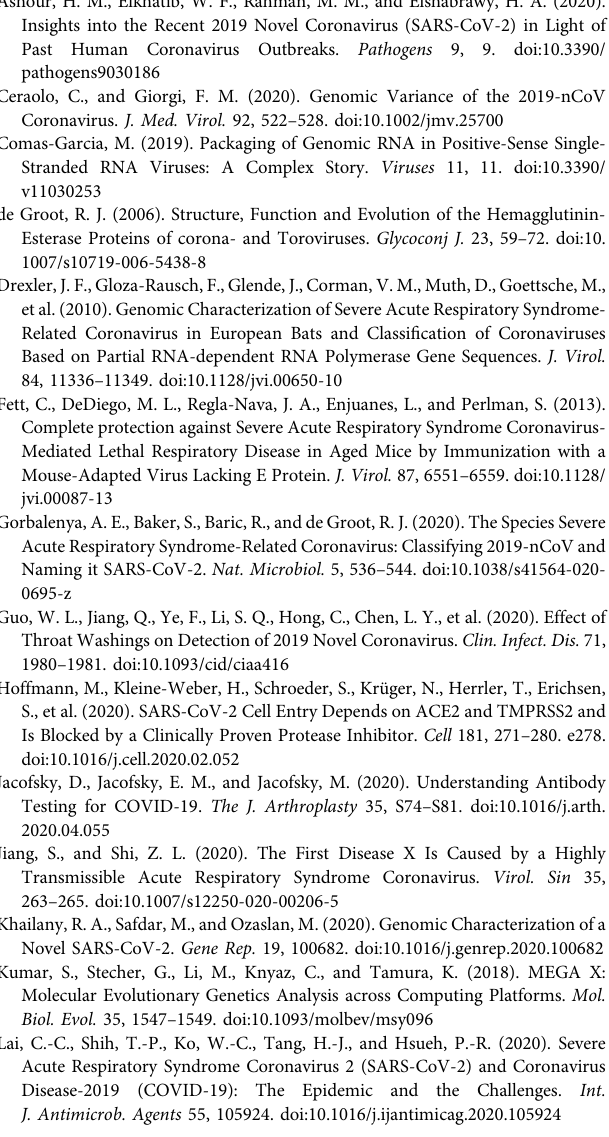
Supplementary Figure S3 | In fl uence of mutations in the S genes of 200 severe acute respiratory syndrome coronavirus-2 (SARS-CoV-2) isolates on protein structure and function. One mutation in the S gene affected protein hydrophobicity (MT263384, p.29Thr → Ile) and one mutation